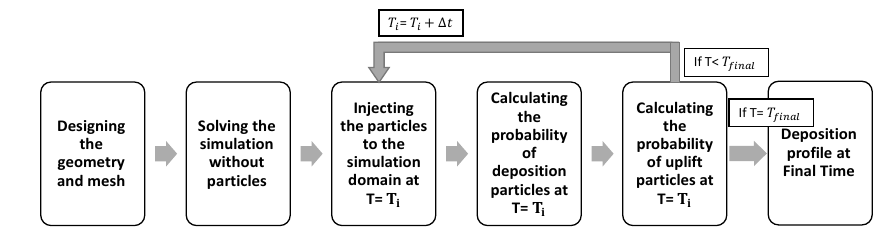
Figure 3. Flow chart of the main steps in the simulation.